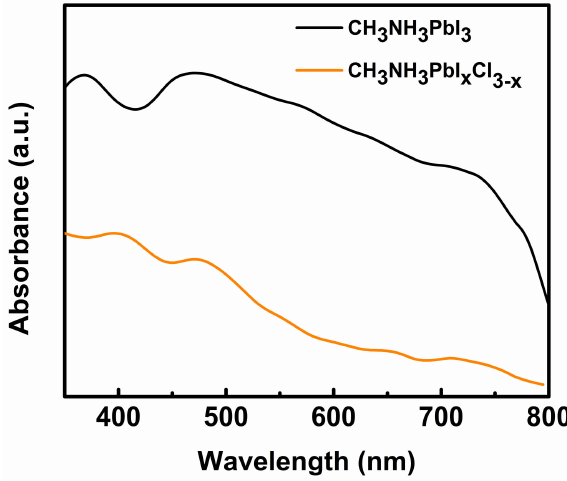
Figure 10. Absorption spectra of some widely used active materials in PVSCs for indoor applications. (Reproduced from [115], with permission from Elsevier,